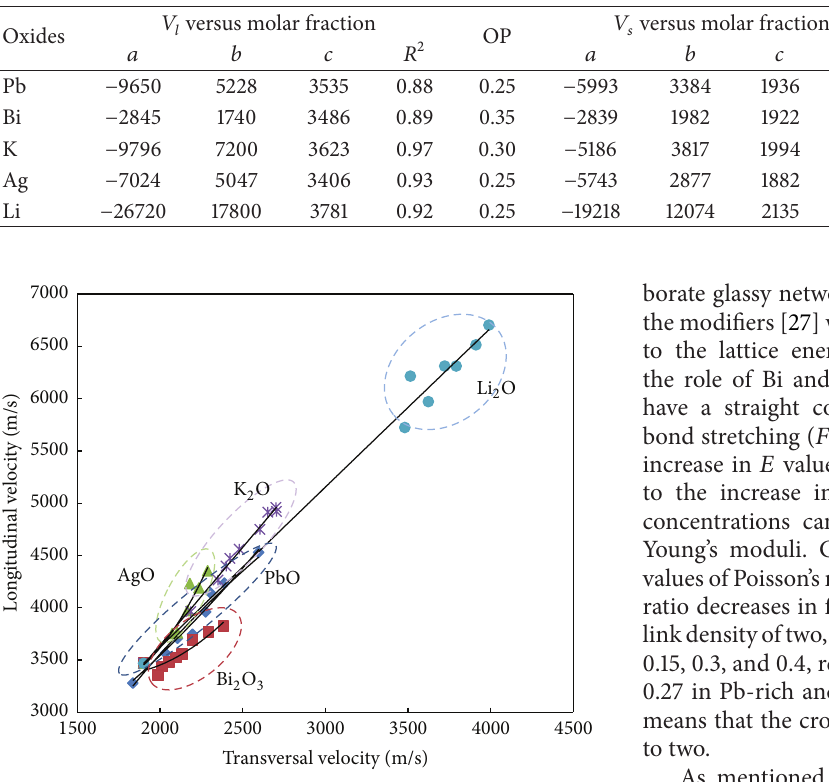
Figure 5: Correlation between transverse ( 𝑉 𝑠 ) and longitudinal ( 𝑉 𝑙 ) ultrasonic velocities in binary borate glasses containing Pb and Bi oxides, as well as oxides of Ag, K, and Li. [22,